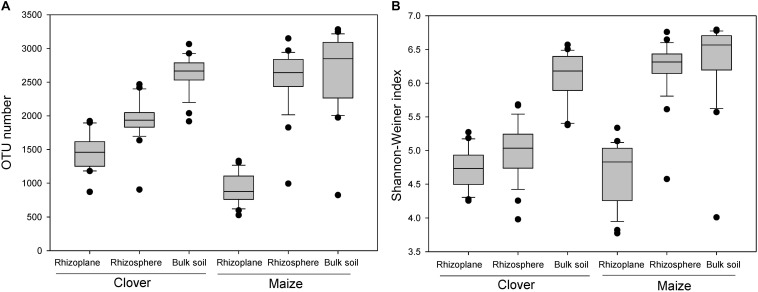
Boxplot of alpha diversity of the bacterial community in different rhizocompartments (rhizoplane, rhizosphere, bulk soil) of maize and clover plants. (A) OTU number; (B) Shannon–Weiner index.